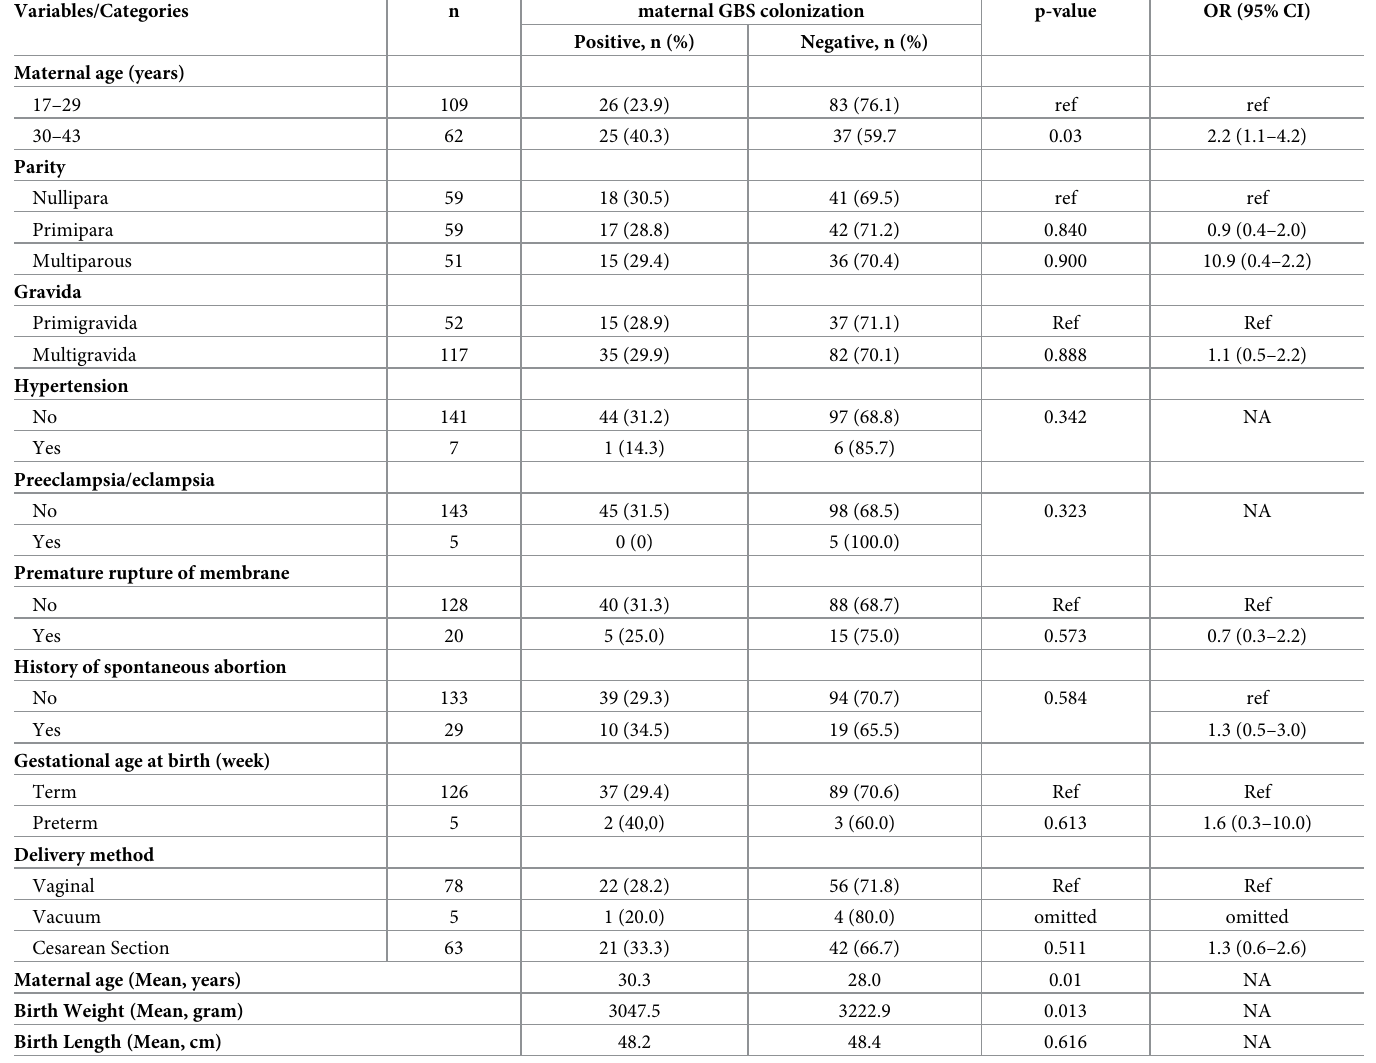
Table 1. Demography and association between risk factors and GBS colonization among pregnant